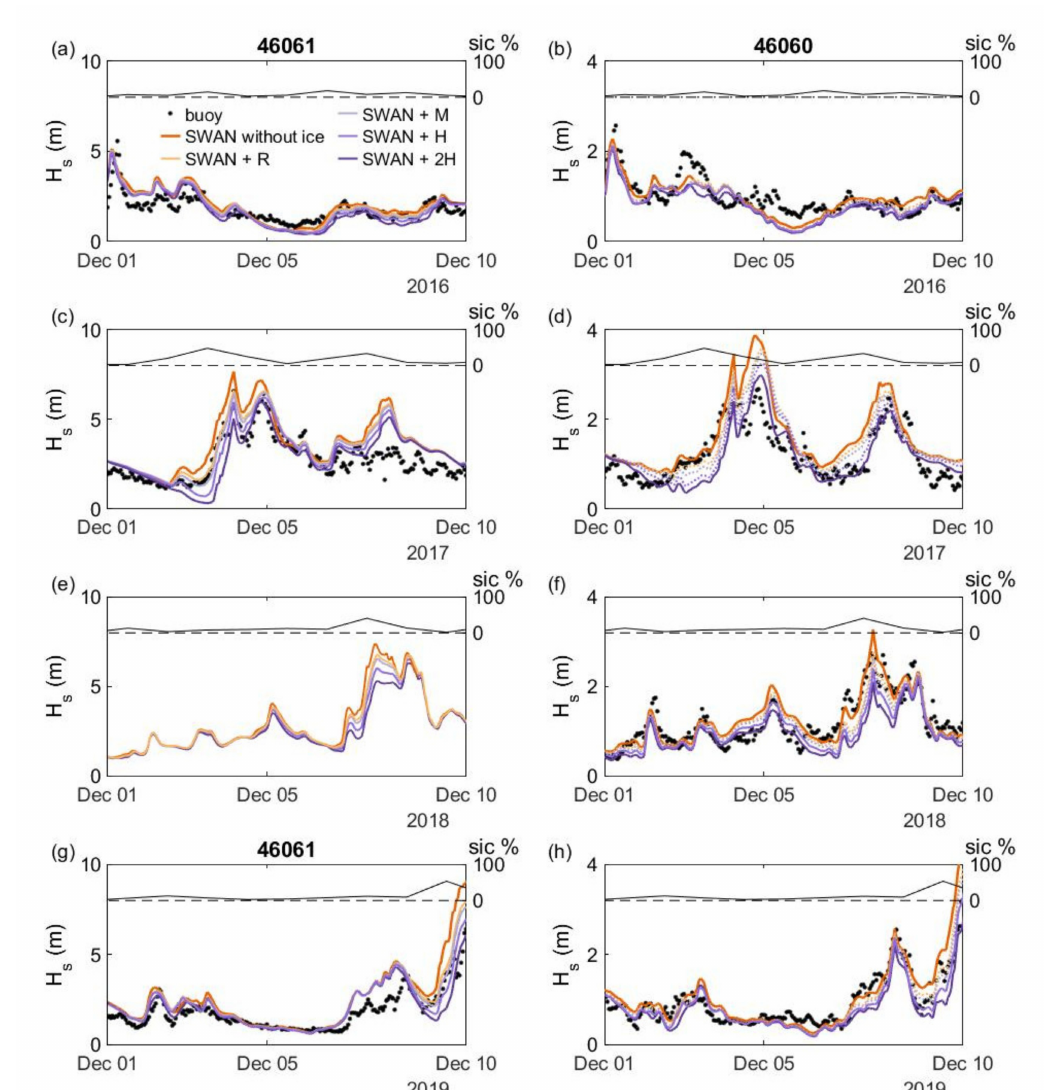
Figure 9. Significant wave height, H s , near the mouth of and inside PWS as measured by wave buoys and modeled by SWAN without ice and with wave/ice interactions modeled with four different sets of coefficients for the first 10 days of December of 2016–2019. Sea ice concentration is shown on the right axis as a black line and 0% is shown as a dashed black line. ( a , c , e , g ) Comparisons at wave buoy 46061 at the mouth of PWS. ( b , d , f , h ) Comparisons at wave buoy 46060 inside of PWS where the waves are smaller. Buoy data were missing for the first 10 days of December 2018 at buoy